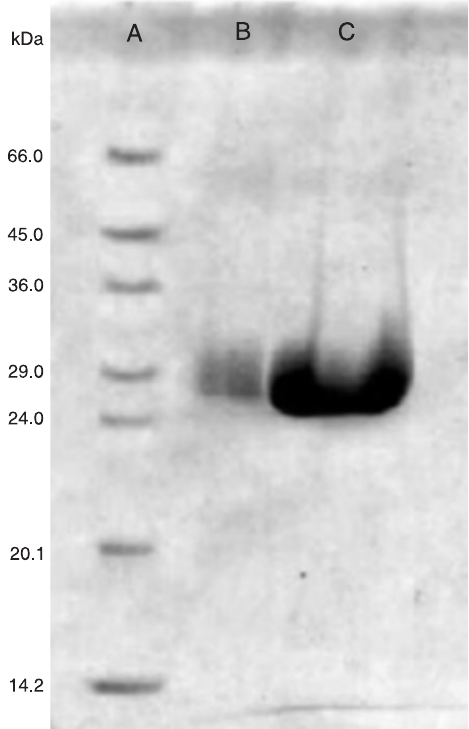
Figure 1. SDS-PAGE of a lectin purified from Solieria filiformis . A , Protein mass standards: 14.2-kDa α -lactoalbumin, 20.1- kDa trypsin inhibitor, 24.0-kDa trypsinogen, 29.0-kDa carbonic anhydrase, 36.0-kDa glyceral- dehyde-3-phosphate dehydro- genase, 45.0-kDa ovalbumin, and 66.0-kDa bovine serum al- bumin. B and C , Purified lectin (5.0 and 20.0 µg,